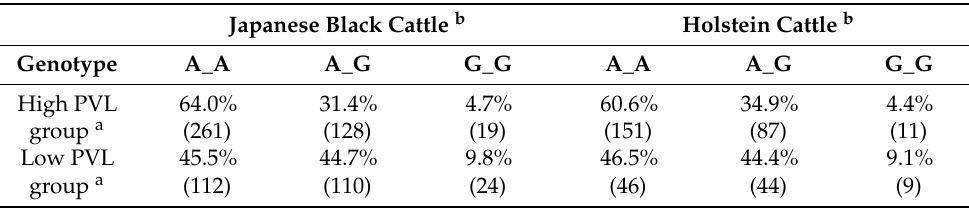
Figure 3. An example of allelic discrimination plots from rhAmp single-nucleotide polymorphism genotyping assay. Allelic discrimination plots for the identified single-nucleotide polymorphism (SNP) (AX-168291905) were obtained using rhAmp SNP genotyping assays on 95 samples with one real-time PCR run. The dots located near the y - and x -axes represent the minor (G_G) and major (A_A) homozygous genotypes, respectively. The dots located far from the y - and x -axes represent the heterozygous genotypes (A_G). Table 2. Proportion of each genotype in identified single-nucleotide polymorphism between high and low bovine leukemia virus proviral load groups.